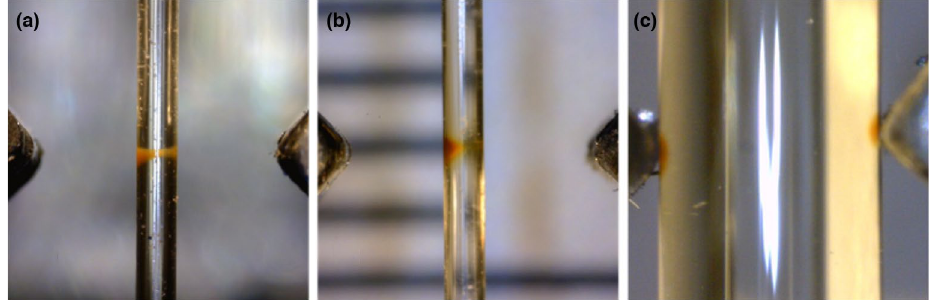
Figure 3. Experimental realization of MNP confinement by permanent magnets separated by 3 mm. ( a) A 500 µm wide capillary is placed at the mid-point between magnets: MNPs are concentrated between the magnets in a clepsydra-shaped region spanning across the entire capillary section. ( b) The 500 µm wide capillary is displaced by 100 µm from the midpoint to the left: MNPs coalesce into a blob-like configuration next to the nearest magnet. ( c) For a 3 mm wide capillary (occupying the entire gap between magnets), the MNPs coalesce into dense blobs next to the magnets.